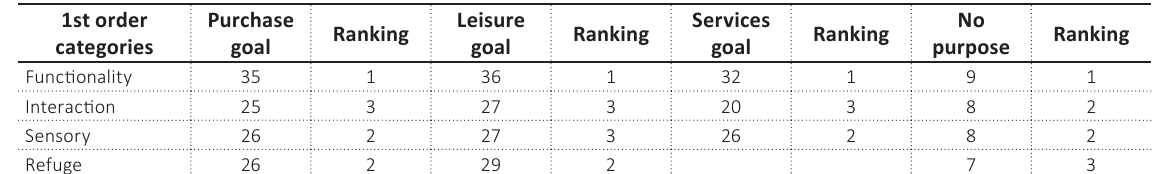
Table 5. Hierarchy of customers’ perceived values and objectives of going to the SC (number of